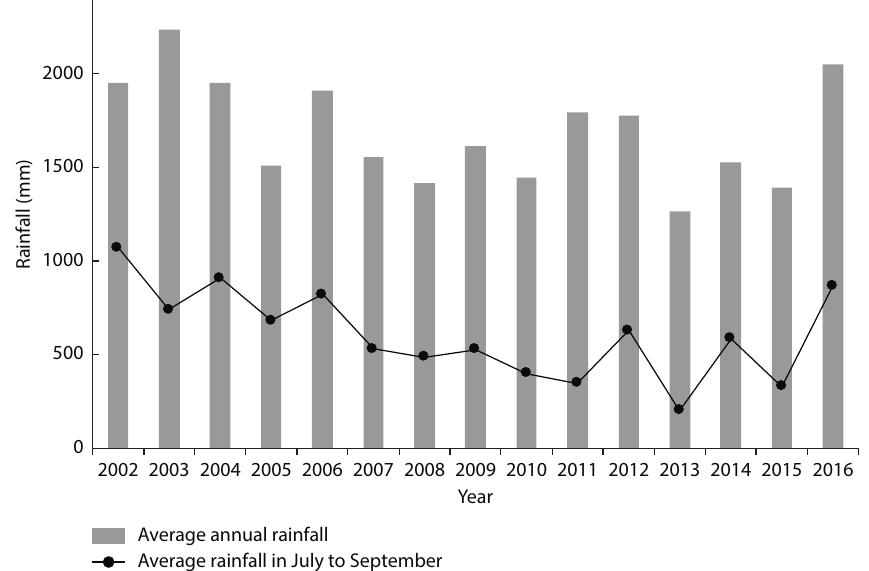
Figure 2: Average annual rainfall in Ulleung-do Island for 15 years and average rainfall pattern from July to